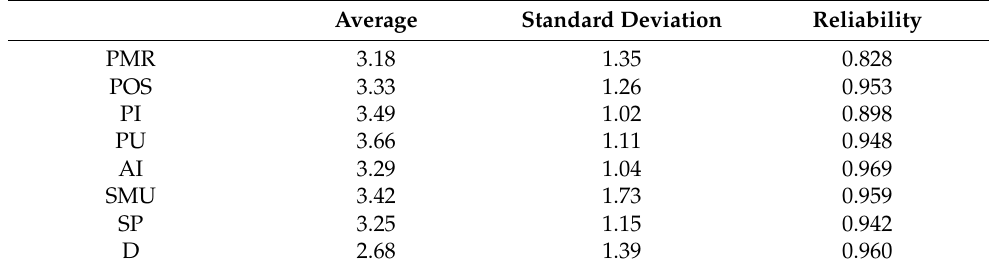
Table 6. Descriptive indicators of the main variables in the sample.